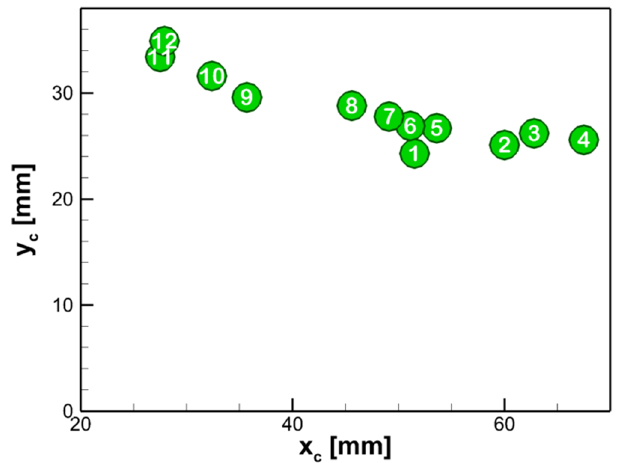
Fig. 5. Positions of mean fl ow vortex in individual branches A – M marked 1 – 13.